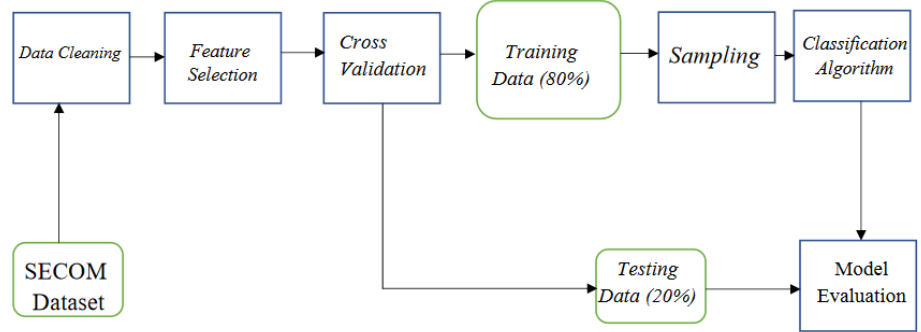
Figure 11. Machine Learning steps for the SECOM dataset. Table 2. Comparing various selection techniques used for feature extraction. Feature Selection